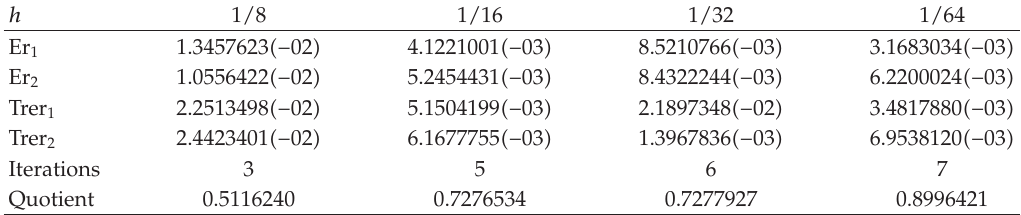
Table 2: Results on the square with a posteriori estimates as a stopping criteria for the first example.